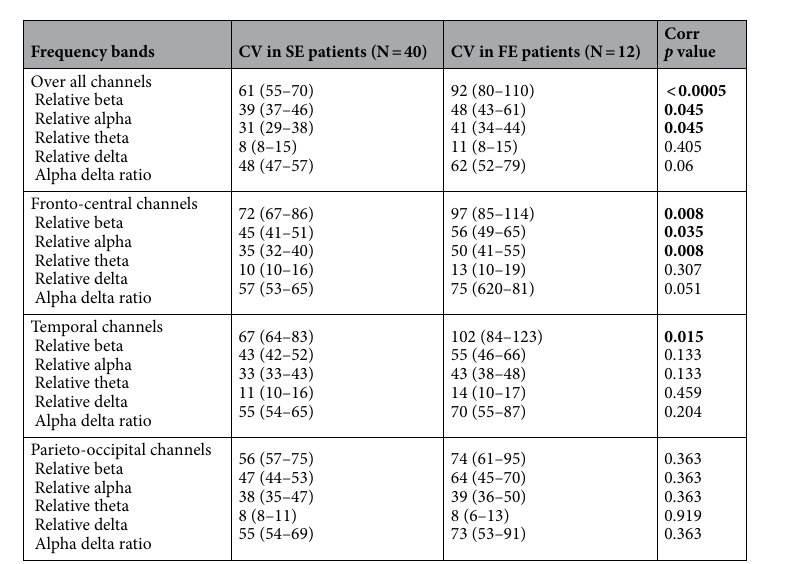
Table 2. Median coefficients of variation (CV) of EEG power frequency bands in patients with successful extubation (SE) versus extubation failure (FE). Corr. p value = corrected p value by Benjamini&Hochberg (False Discovery Rate), CV = coefficient of variation, FE = Failed extubation, SE = Successful extubation; univariate testing using Mann–Whitney U test, all values in %, numbers in brackets indicate 95% confidence interval. Significant values are in